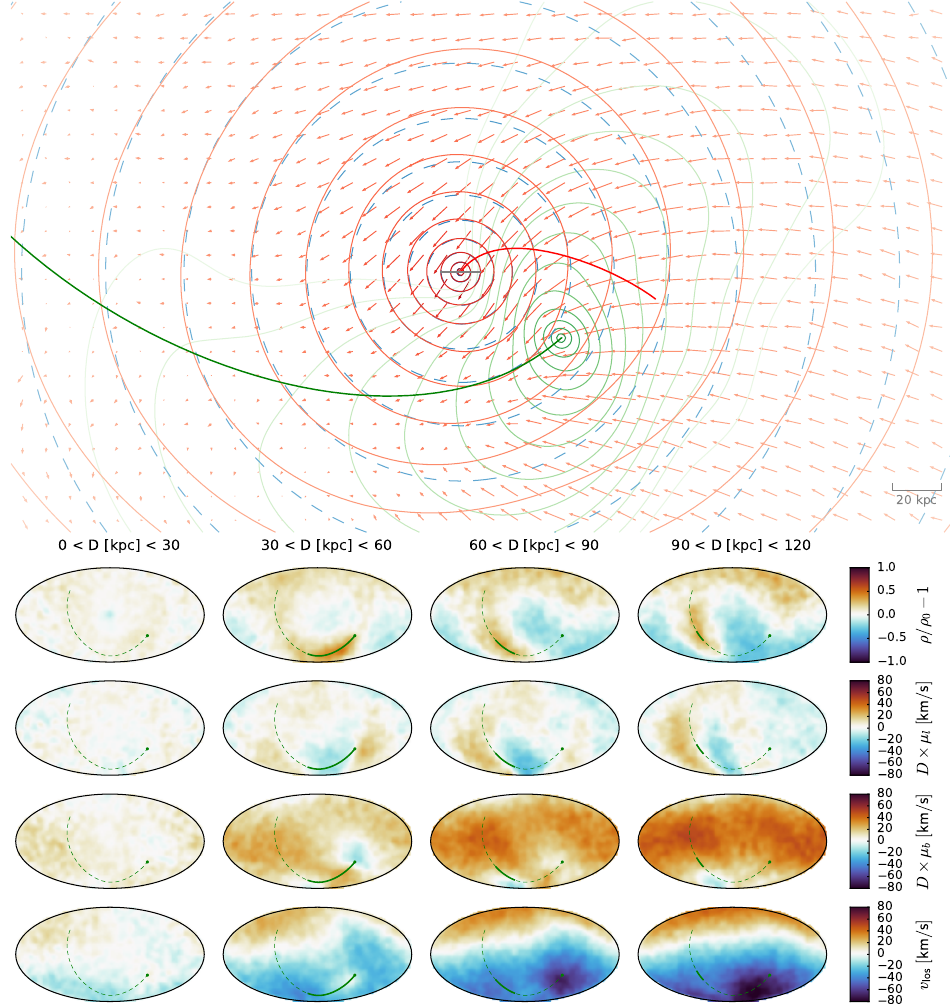
Figure 5. Top panel: side view of the final snapshot in the N -body simulation of a Milky Way–LMC interaction. The Galactic disc is oriented edge-on (grey line), and the Sun’s position is directly in front of the image plane, which is close to the orbital plane of the LMC. The past trajectories of both galaxies are shown by red and green curves. Red and green contours show the projected density of the Milky Way and LMC haloes, respectively, while the dashed blue contours show the initial Milky Way halo (spherical). Regions where the red contours are closer to or further away from the Galactic centre than the blue ones appear as under- or overdensities, respectively. Arrows display the mean velocity of Milky Way particles in the centre-of-mass frame, which reaches 60 km s − 1 in the central region. In the non-inertial reference frame associated with the Galactic centre, the mean velocity in the central 20–30 kpc is close to zero, but in the outer regions it is primarily directed upward (one needs to subtract the central velocity vector from all vectors shown in the plot). Bottom panel: the same snapshot as viewed from the Solar location at rest with respect to the Galactic centre (i.e., corrected for the Solar motion). Shown are sky maps of over/under density (top row), mean velocity in the l and b directions (PM multiplied by distance, second and third rows), and mean line-of-sight velocity (bottom panel). The snapshot is split into four bins in heliocentric distance, shown in columns from left to right. The innermost one has very little perturbation in either density or kinematics, but it becomes progressively larger further out. Apart from localised overdensities along the past LMC orbit, the dominant feature is the north–south dipole asymmetry in density and line-of-sight kinematics, and the positive mean v b (upward motion in the sky plane) in the outer